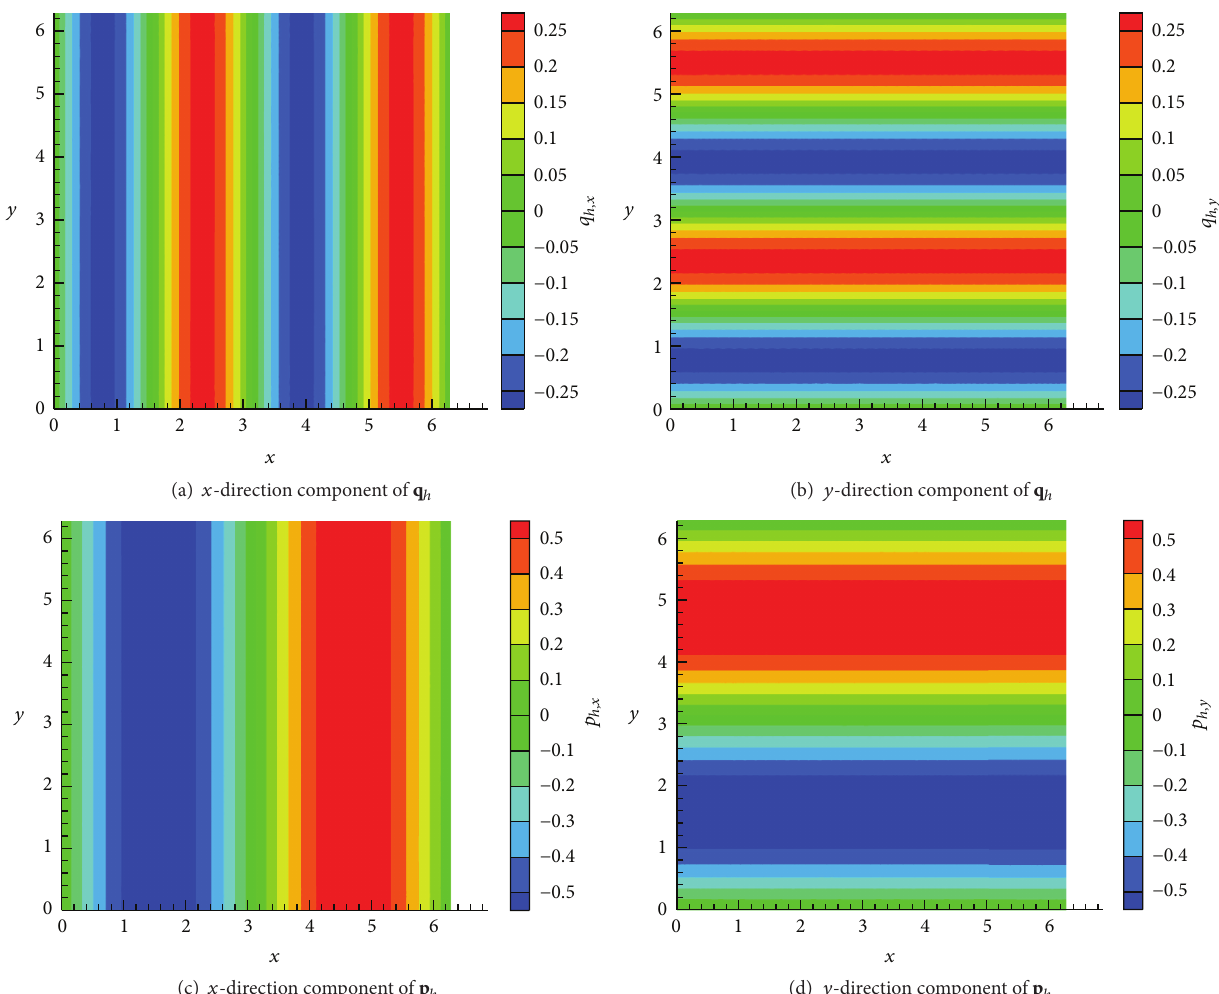
Figure 4: Numerical approximates for fluxes q (top) and p (bottom) at 𝑇 = 0.5 under the partition shown in Figure